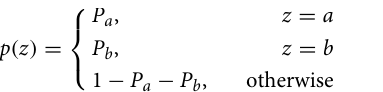
where z represents the pixel intensity. P a and P b are probabilities. a and b are two constants. The intensity b will appear as a light dot in the image. Conversely, level a will appear like a dark dot 36 . What is striking in Table 7 is the dramatic difference between the two noise modes. The reconstructed image quality of mode I is significantly higher than that of mode II. It shows that there has been a sharp decline in the image quality when the noise changes from dark dots to light dots. The results reveal that all components are sensitive to light dots and more robust to dark dots. For the sake of clarity in the visualization, we show the reconstructed image with noise in Fig. 4. Each compo- nent is decoded after adding salt and pepper noise (mode I). Figure 4b and c have some distortion in the upper right and lower left regions compared with the original image. However, Fig. 3d–g are almost indistinguishable to the naked eye. This reveals the difference in the robustness of each component to such a kind of noise. Gaussian noise. Gaussian noise models are used frequently in practice because of their mathematical trac- tability in both the spatial and frequency domains 36 . In fact, it is often used to model additive noise. The prob- ability density function of Gaussian noise is given by